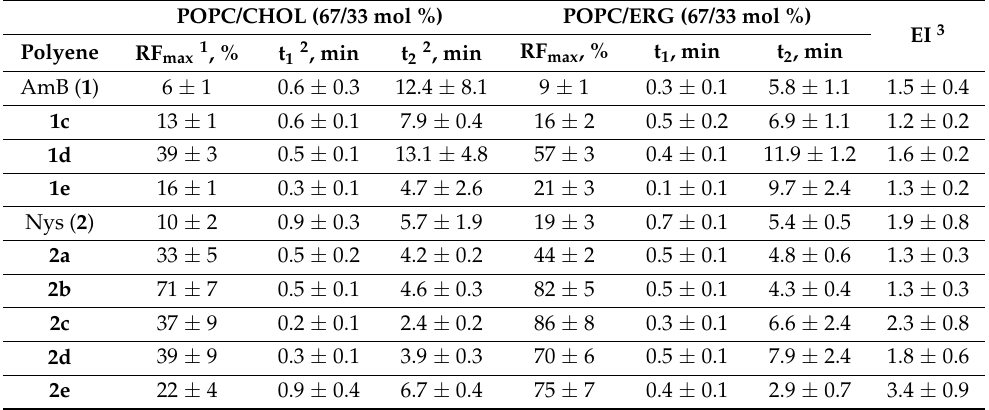
Table 3. The characteristic parameters of the dependence of calcein release from large unilamellar vesicles of indicated composition induced by 5 µ M of antibiotic on time.